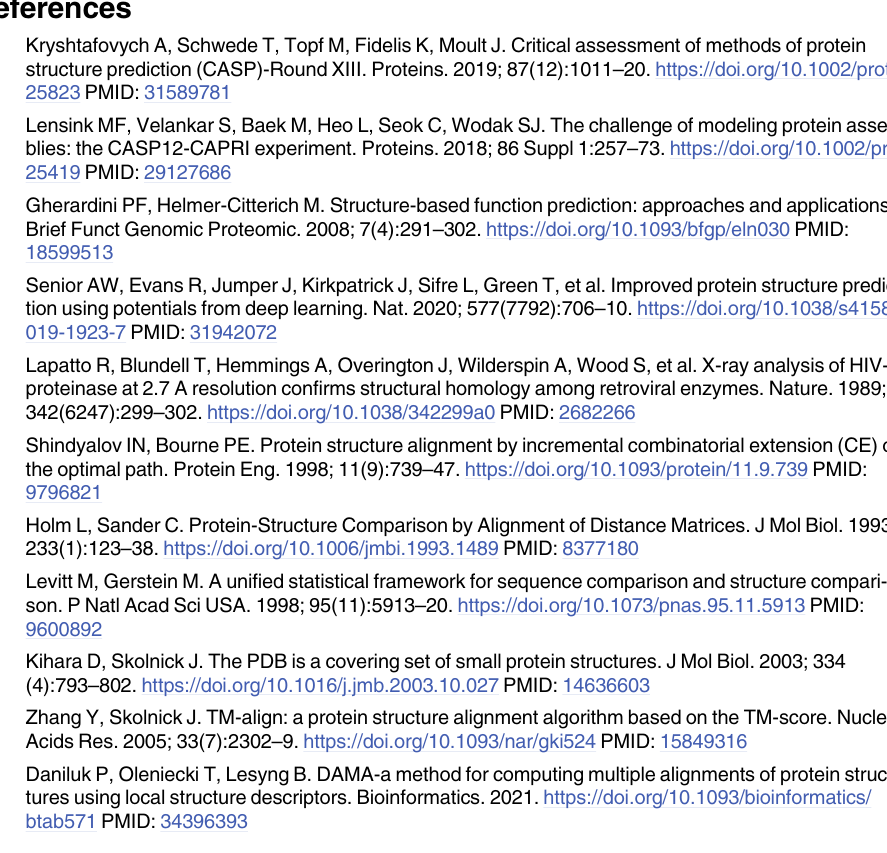
(perplexity = 100). Fig C: Visualization of descriptors learned from GraSR and other methods by t-SNE